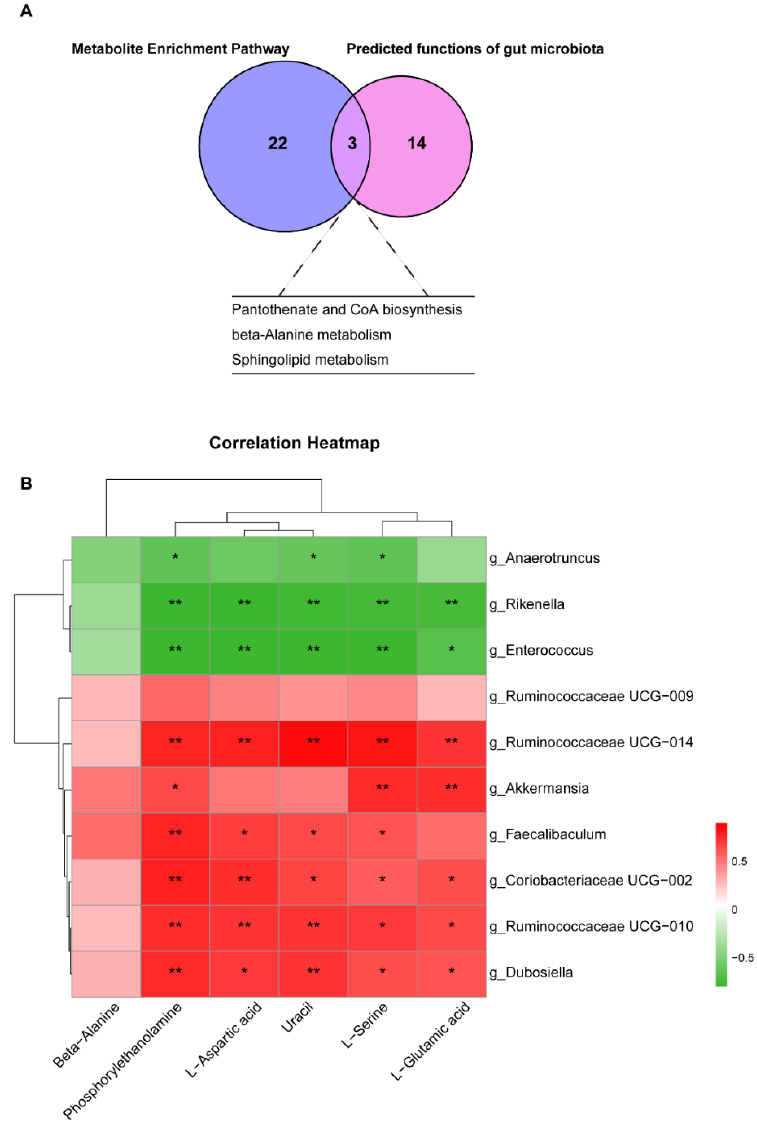
Figure 6. Key liver metabolites and gut microbiota affected by FFAR4. ( A ) Venn diagram analysis. ( B ) Correlation analysis of differential bacterial genera and metabolites. * p < 0.05 and ** p < 0.01.